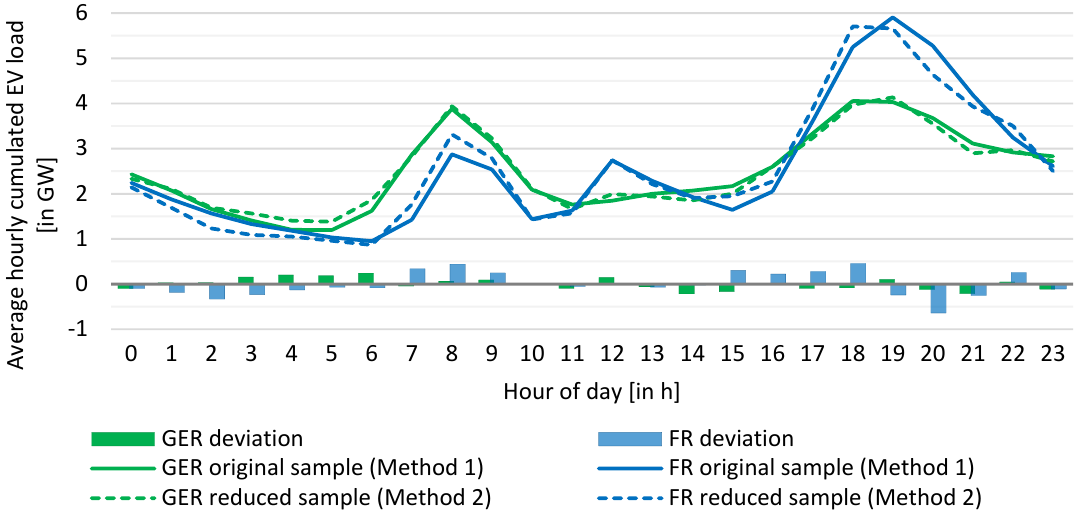
Figure 4. Average hourly cumulated PEV load of original and reduced sample directly charging in 2030.